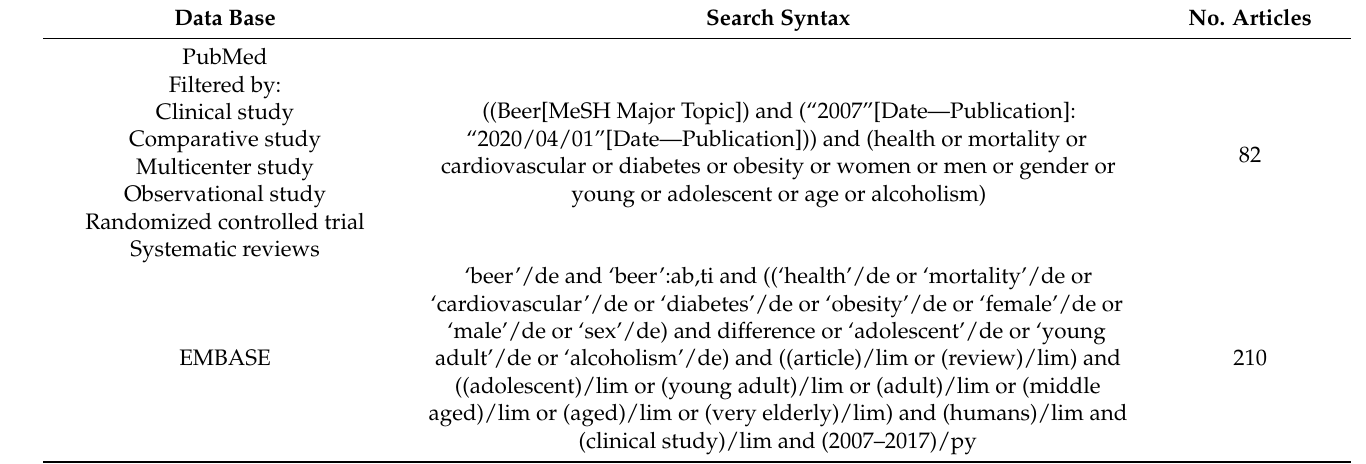
Table 2. Literature search